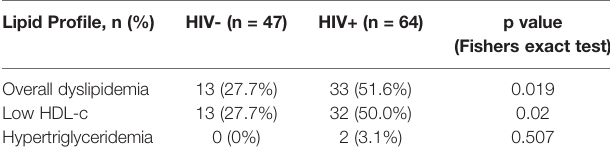
TABLE 2 | Prevalence of dyslipidaemia in HIV- and HIV+ children.